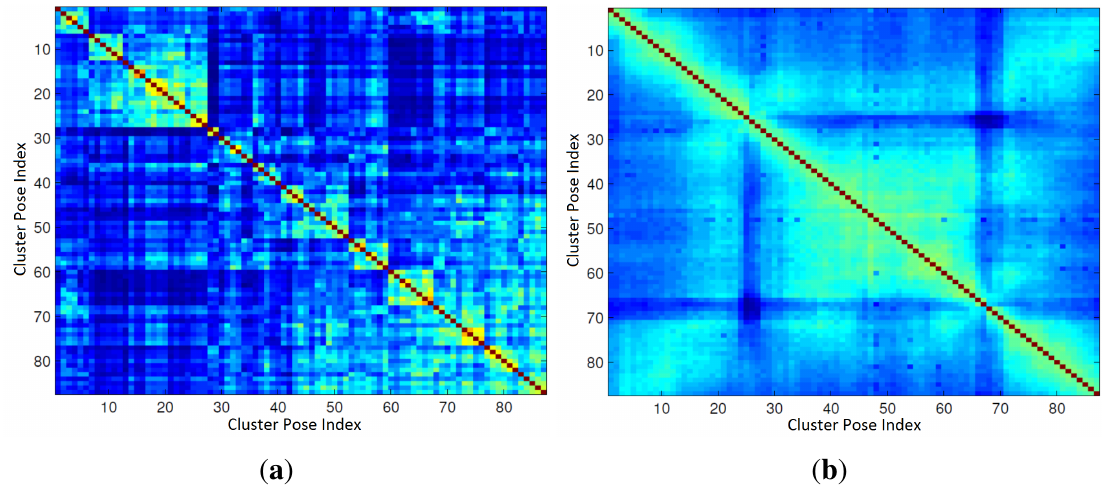
Figure 9. ( a ) The correlation matrix of a cluster before optimization of pairwise constraints. ( b ) The correlation matrix after FICP has been run on the pairwise